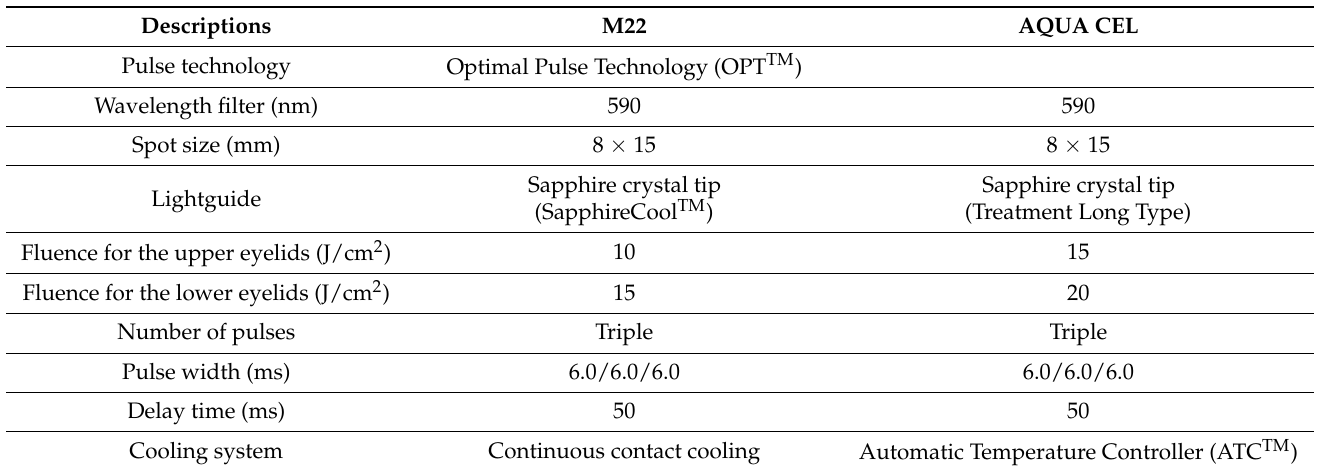
Table 1. Differences in systems and settings between the two intense pulsed light (IPL)